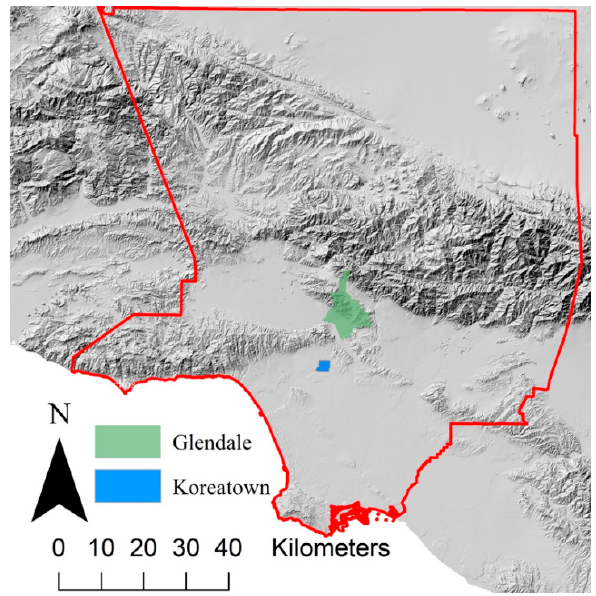
Figure 2. The location of the two study sites for evaluation of green roofs and photovoltaic panels on building Energy Savings: Glendale and Koreatown, Los Angeles County, California, USA.